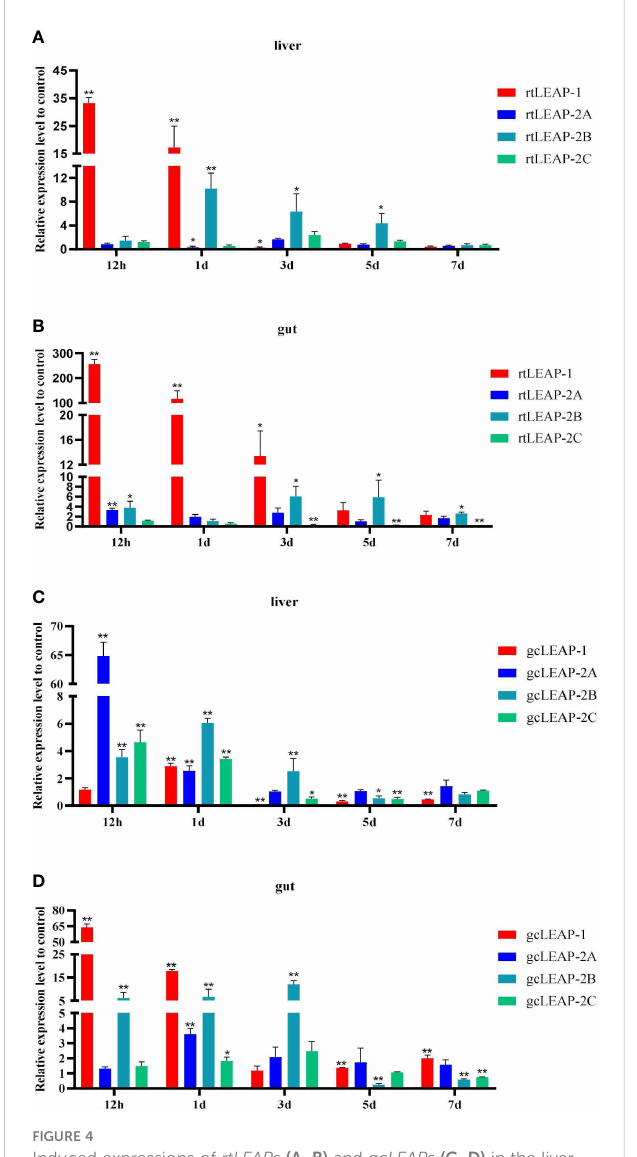
FIGURE 4 Induced expressions of rtLEAPs (A, B) and gcLEAPs (C, D) in the liver and gut under the condition of infection. Fold changes were calculated by comparing the infected group with the control group (de fi ned as 1) using the 2 − DD Ct method. Data represent the mean ± SEM of four fi sh individuals. The p value was calculated by one-way ANOVA with a Dunnett post hoc test (* p < 0.05, ** p < 0.01).